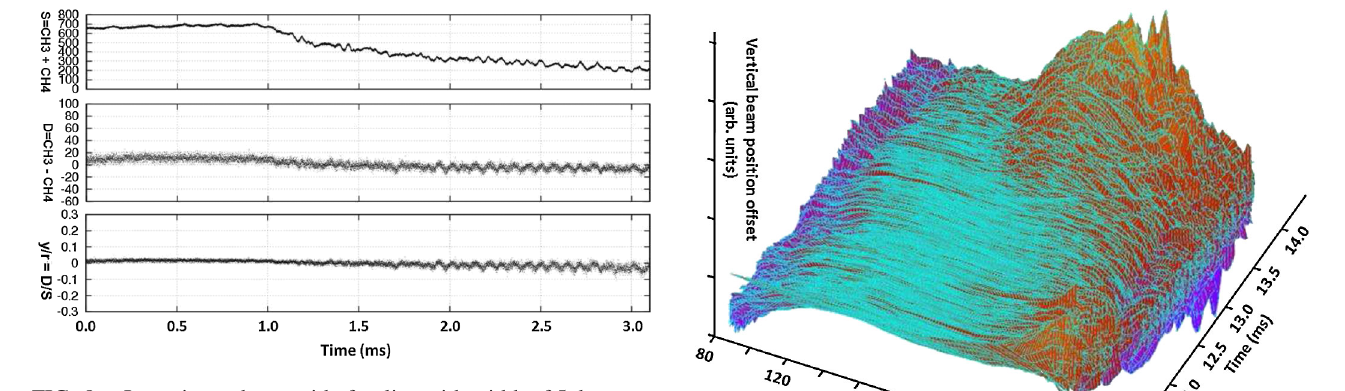
8. Intensity and centroid of a slice with width of 5 degrees of rf phase at 152 degrees in the bunch head for 3.2 ms before extraction. Upper: sum BPM signal; middle: difference BPM signal; bottom: the ratio, centroid deviation. CH3,4: the top and bottom BPM signals. In the figure, t ¼ 0 refers to approximately 11 ms in the